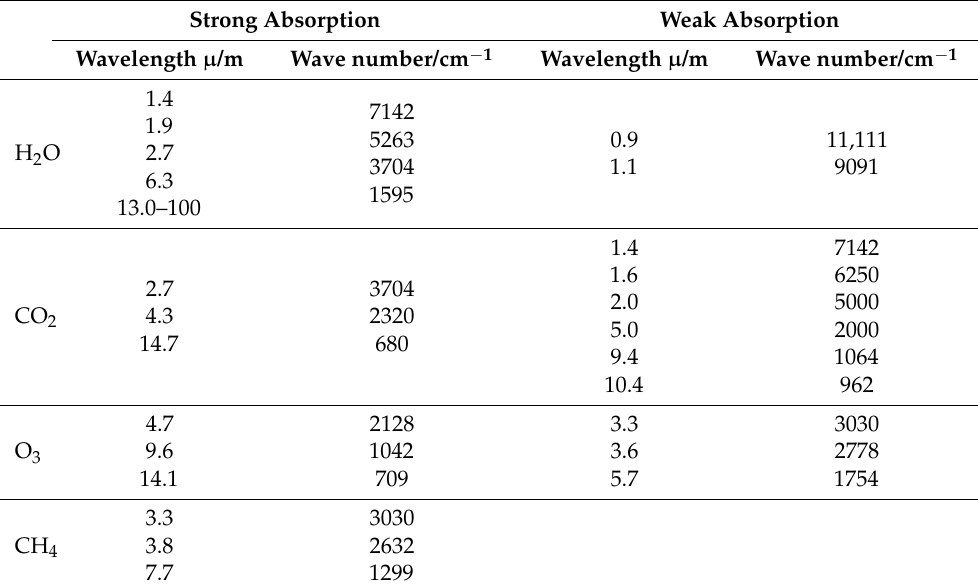
Table 1. Absorption bands of major atmospheric